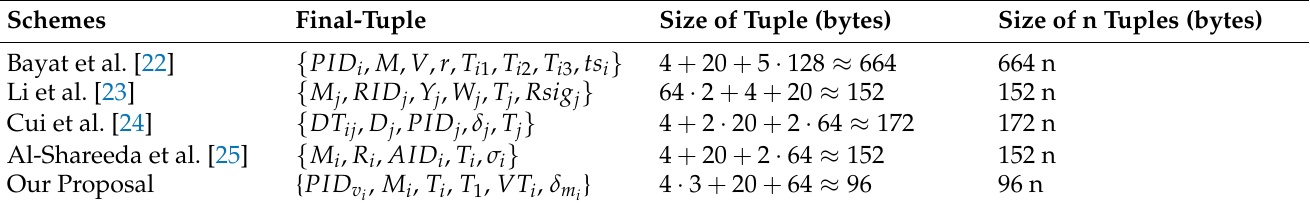
Table 5. Costs of Different Methods of Contact Compared.